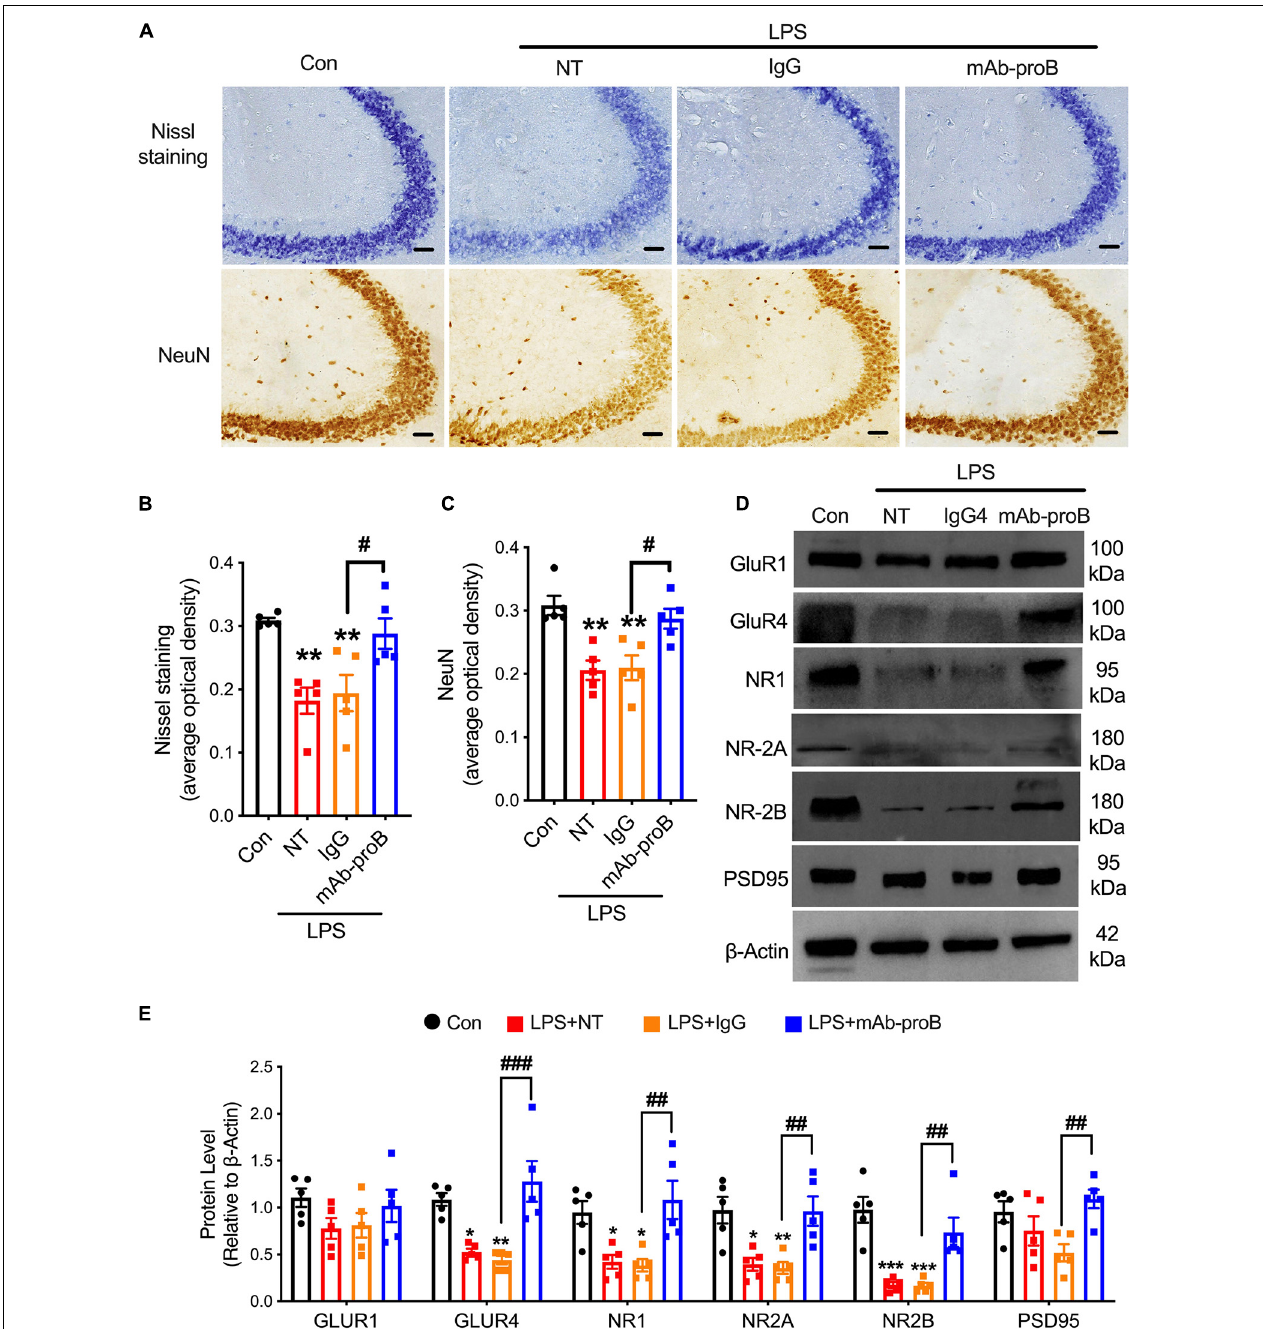
FIGURE 6 | MAb-proB upregulated the expression of neuronal cells and synapse-associated proteins in sepsis-associated encephalopathy mice. (A–C) Representative images and quantitation of Nissl bodies and NeuN-positive neuronal cells (scale bar = 50 µ m, n = 4/group). (D,E) Immunoblot analysis of GluR1, GluR4, NR1, NR-2A, NR-2B, and PTSD95 ( n = 5/group). Data are expressed as mean ± SEM. * p < 0.05, ** p < 0.01, *** p < 0.001 vs. control; # p < 0.05, ## p < 0.01, ### p < 0.001, LPS + IgG vs. LPS + mAb-proB.